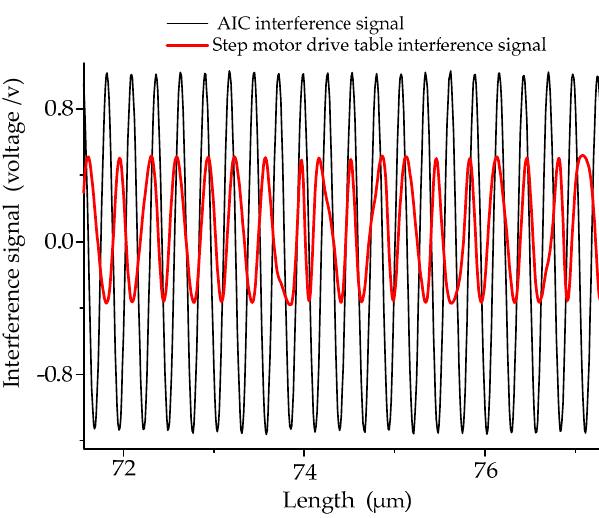
Figure 10. Signal difference in different driving modes. AIC is automatic interference comparator.